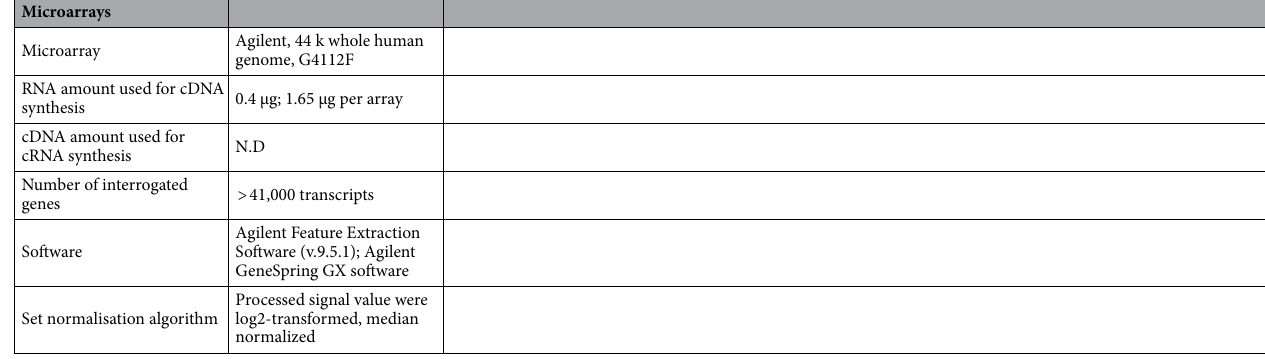
Table 2. Overview of methodological details of either qRT-PCR or microarrays used by the contributing teams. The sequence of topics from top to bottom reflect a typical workflow for gene expression analysis starting with the isolation of RNA, quality and quantity controls, cDNA synthesis and qRT-PCR.